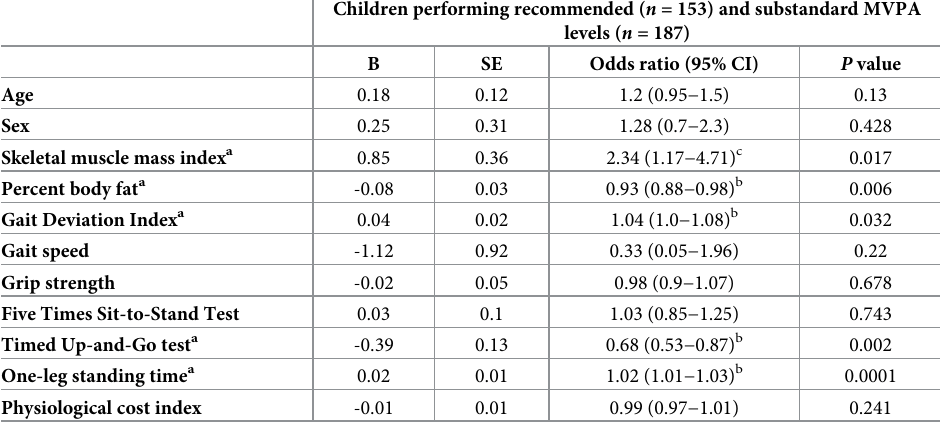
a Logistic regression analyses revealed that skeletal muscle mass index, percent body fat, Gait Deviation Index score, Timed Up-and-Go test results, and one-leg standing time were independently associated with MVPA.